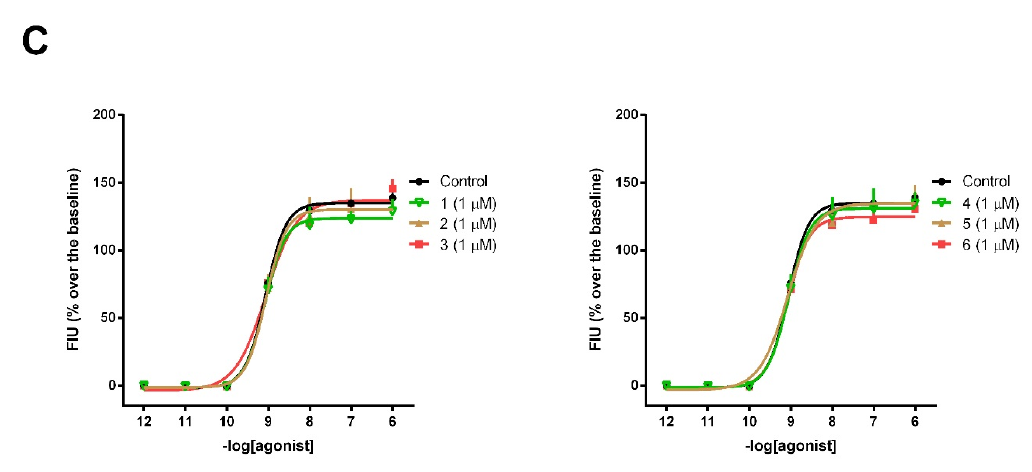
Figure 3. Calcium mobilization assay. Concentration–response curves to dermorphin ( A ), DPDPE ( B ) and dynorphin A ( C ) obtained in the absence (control) and presence of the tested compounds. Data are the mean ± SEM of 3 separate experiments made in duplicate, p < 0.05 vs. control, according to one-way analysis of variance (ANOVA) followed by the Dunnett’s post hoc test. FIU, fluorescence intensity units.